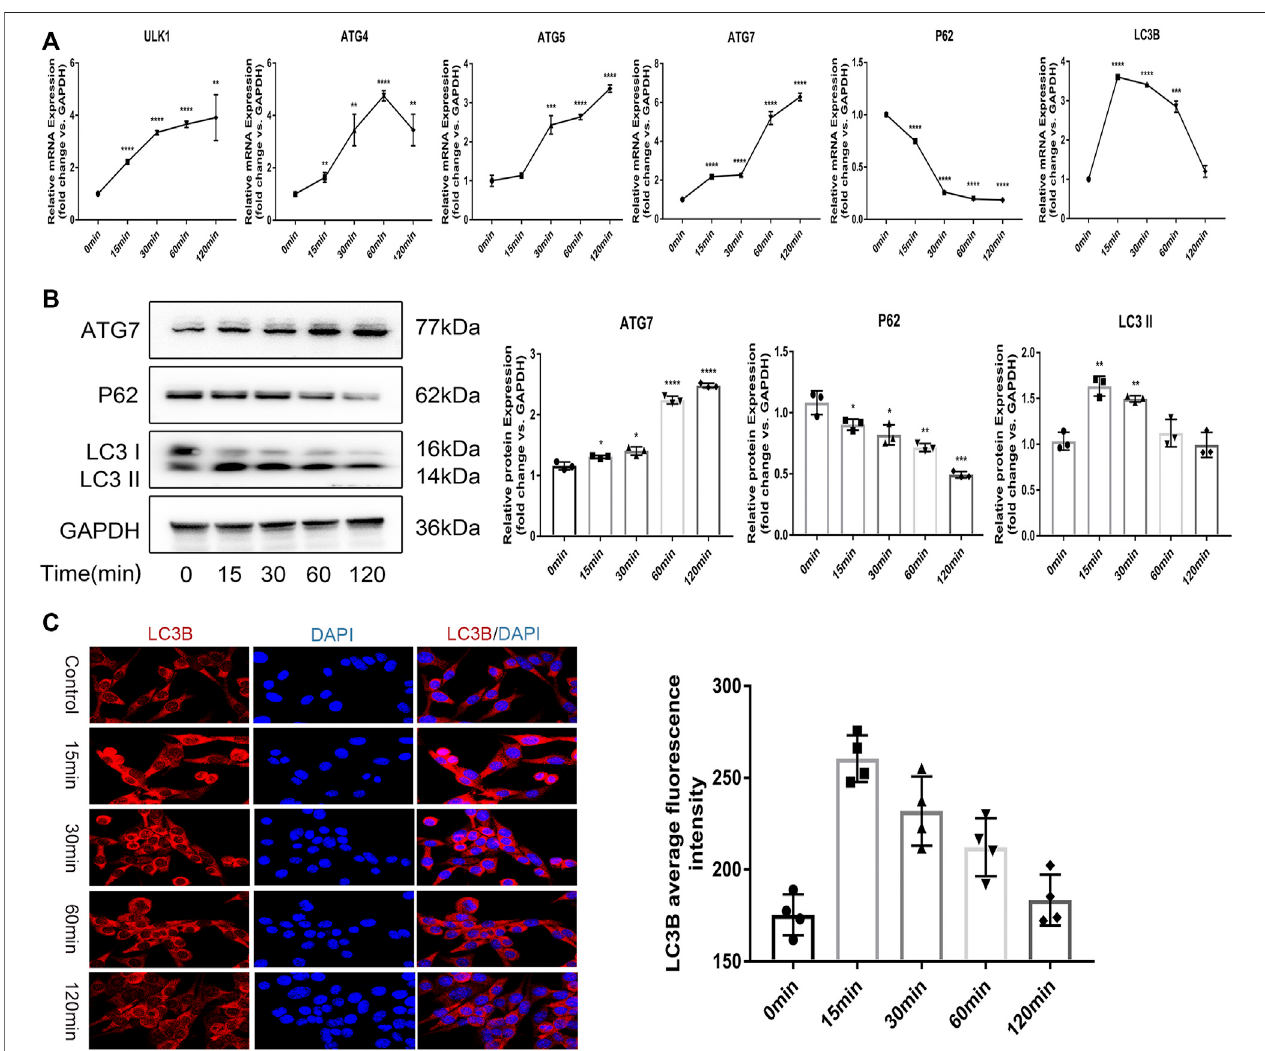
FIGURE 2 | In vitro mechanical tension induces autophagy in osteocytes (A) The mRNA expression of ATG4 ATG5 ATG7 LC3B ULK1 were detected by realtime RT-PCR. GAPDH was used for normalization. (B) The protein expression of ATG7 P62 and LC3B were measured by western blot. The quanti fi cation of ATG7 P62 and LC3BII. GAPDH was used for normalization. (C) Immuno fl uorescence staining was used to visualize autophagosomes (respresented by LC3 positive spots). Scale bar (cid:2) 10 μ m. All cell experiments were repeated 3 times and each time they were performed in at least 3 replicate wells. All data were showed as mean ± SD. * p ˂ 0.05 vs .